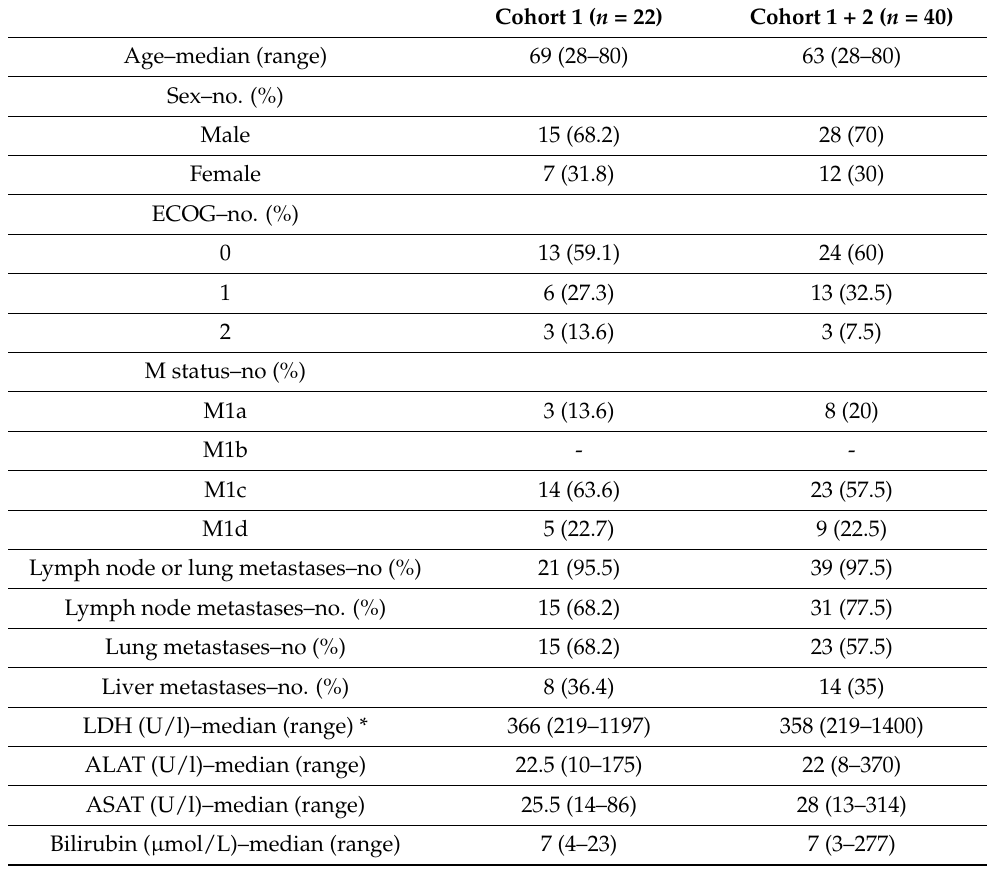
Table 1. Patient characteristics.